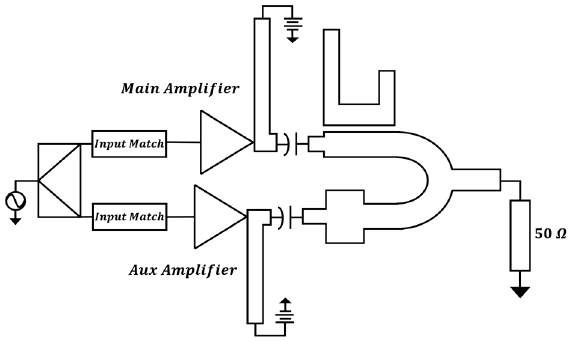
Figure 2. Proposed Doherty Output Combiner.